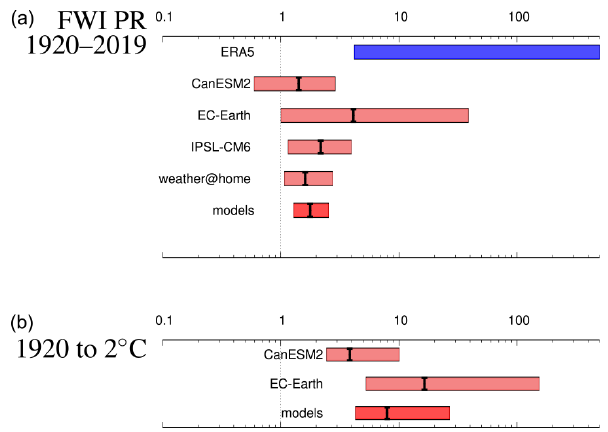
Figure 6. (a) The PR for an FWI as high as observed in 2019/20 or higher: (a) from 1920/21 to 2019/20 and (b) from 1900 to a cli- mate globally 2 ◦ C warmer than 1920. The last row is the weighted average of all models, the spread of which is consistent with only natural variability. (b) Same for a 2 ◦ C climate (GMST change from the late 19th century).